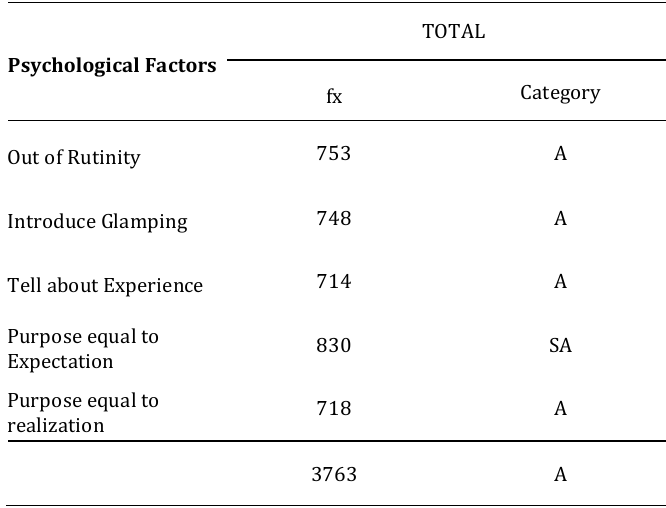
Table 3 Data analysis of psychological